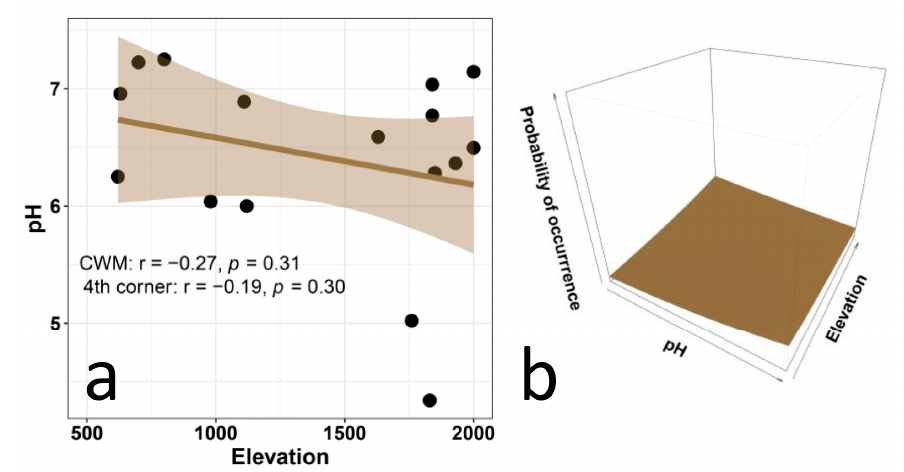
Figure 6. Relationship between Ellenberg indicator values for reaction (pH) and elevation in plant communities along an elevational gradient in Central Italy. The left panel ( a ) presents the CWM regression model and statistical corrections based on the fourth-corner analysis. The right panel ( b ) presents the results of the multi-level model (trait × environment interaction p = 0.45, marginal R 2 = 0.003).